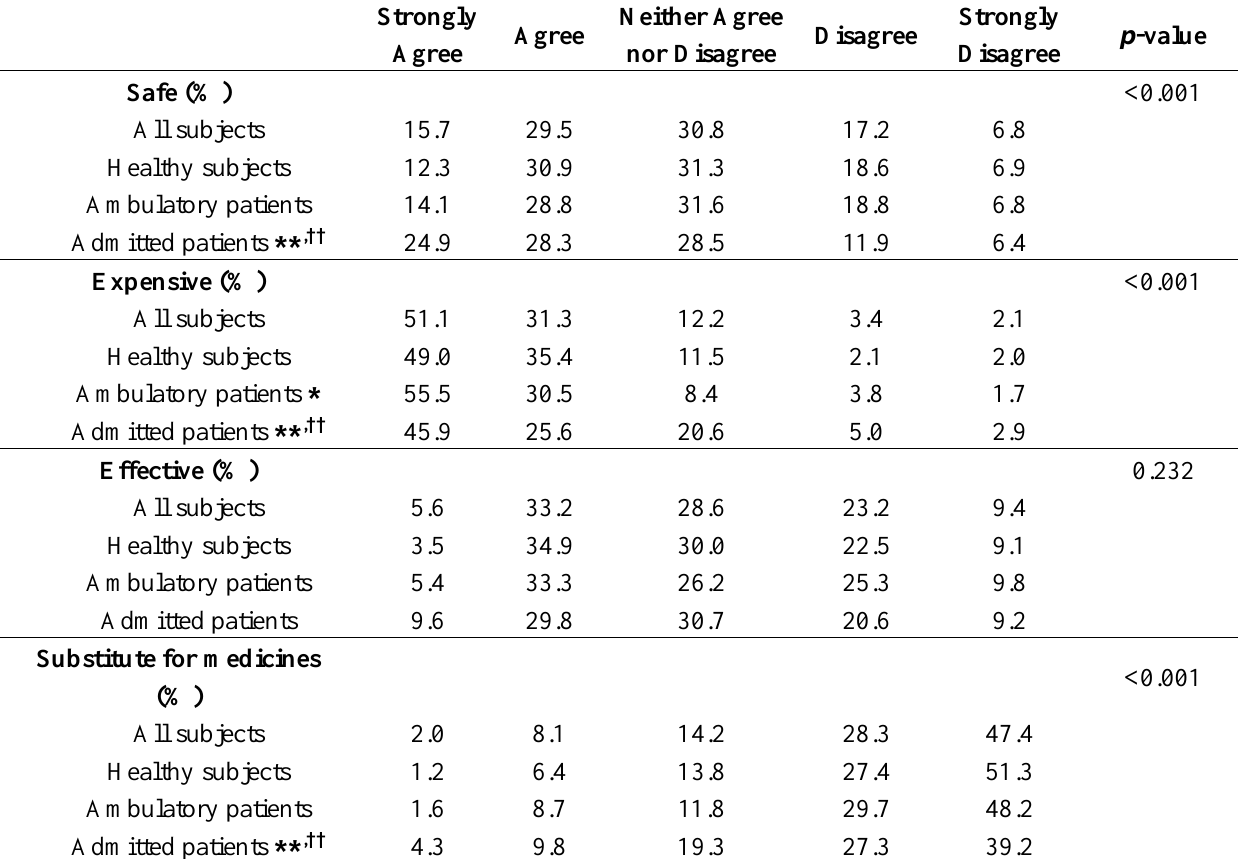
Table 2. Awareness of dietary